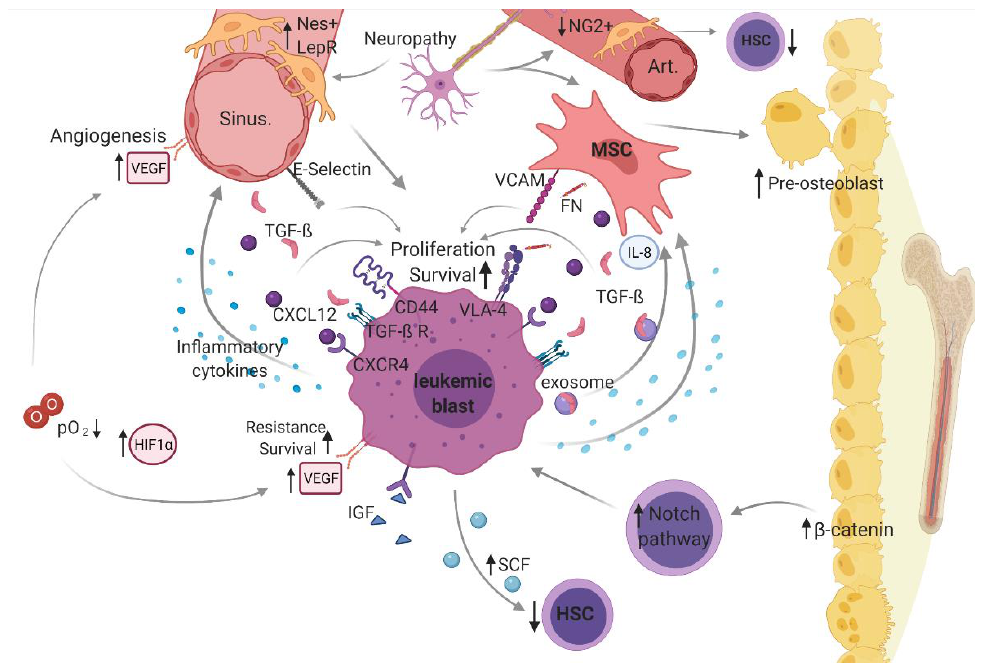
Figure 2. Leukemic bone marrow microenvironment.